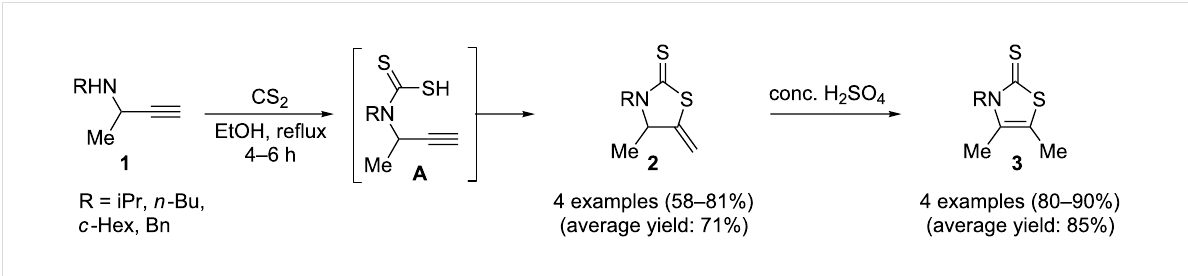
Scheme 1: The synthesis of thiazole-2-thiones 3 through the thermal cyclocondensation of N -propargylamines 1 with carbon disulfide as developed by Batty and Weedon [75].